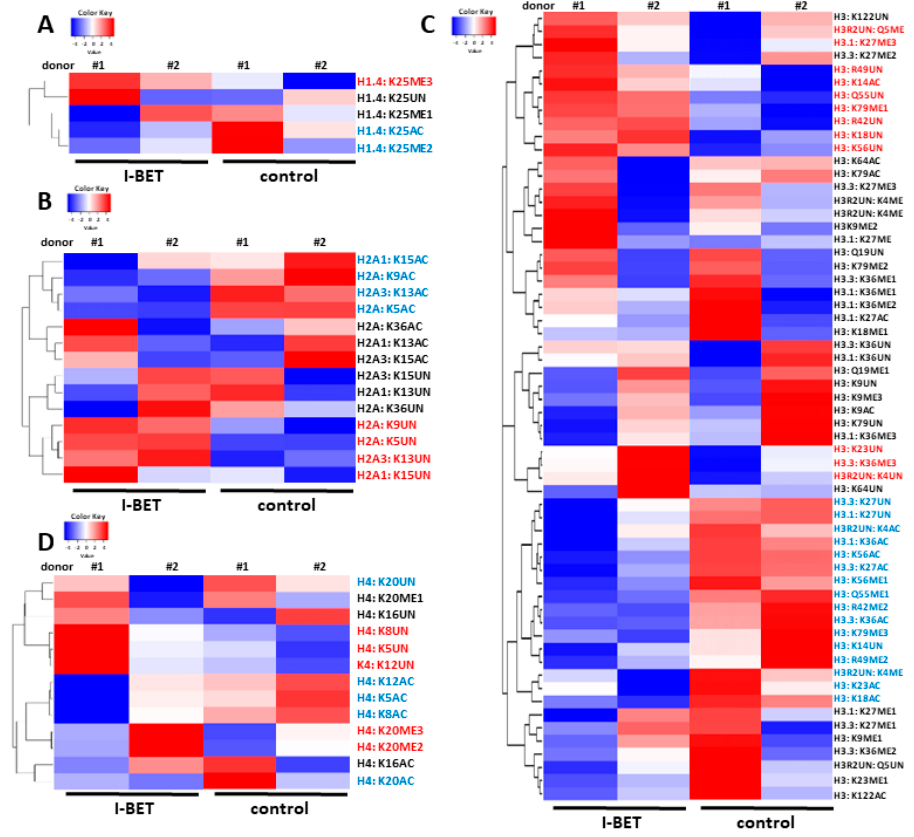
Figure 2. I-BET151-induced changes in FLSs assessed by mass spectrometry. Heatmaps of relative abundancies of histone modi fi cations on ( A ) histone 1 (H1), ( B ) histone 2 (H2), ( C ) histone 3 (H3), and ( D ) histone 4 (H4). I-BET151-induced increases in histone modi fi cations are highlighted in red, the I-BET151-induced suppression of histone modi fi cations is highlighted in blue.